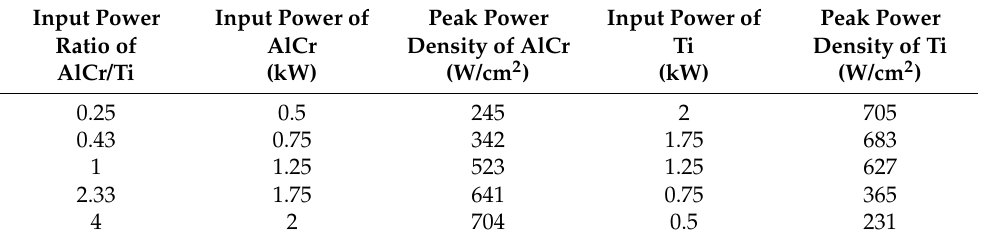
Table 2. The discharge characterizations of Ti and AlCr targets operated by the HiPIMS